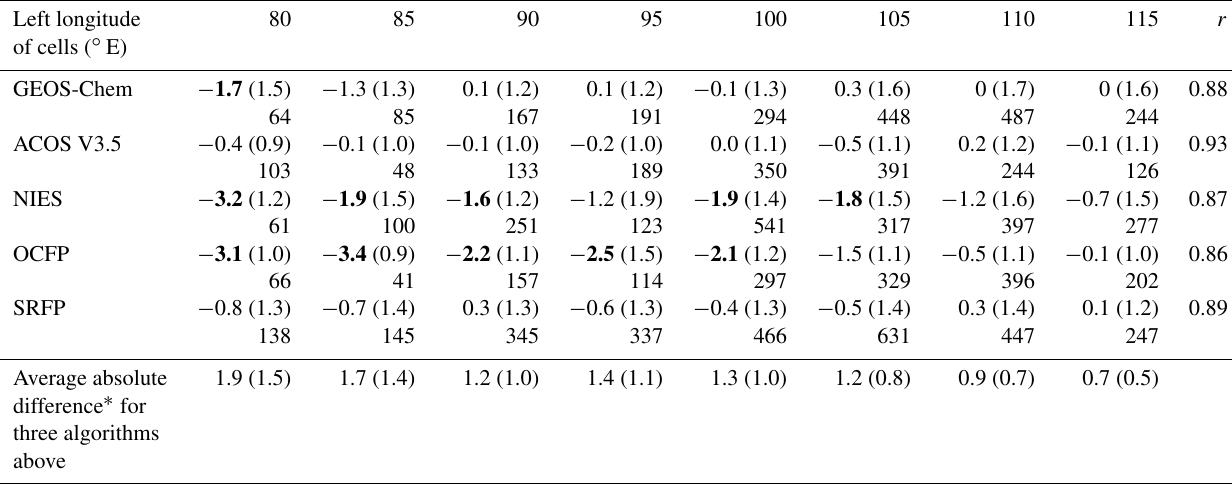
Table A1. Differences between ACOS V7.3 and the other five data sets utilized (including GEOS-Chem and the four other algorithms, namely: ACOS V3.5, NIES, OCFP and SRFP) in each cell (subtraction from ACOS V7.3). Values in parentheses are the corresponding SDs. The differences larger than 1.5ppm are highlighted in